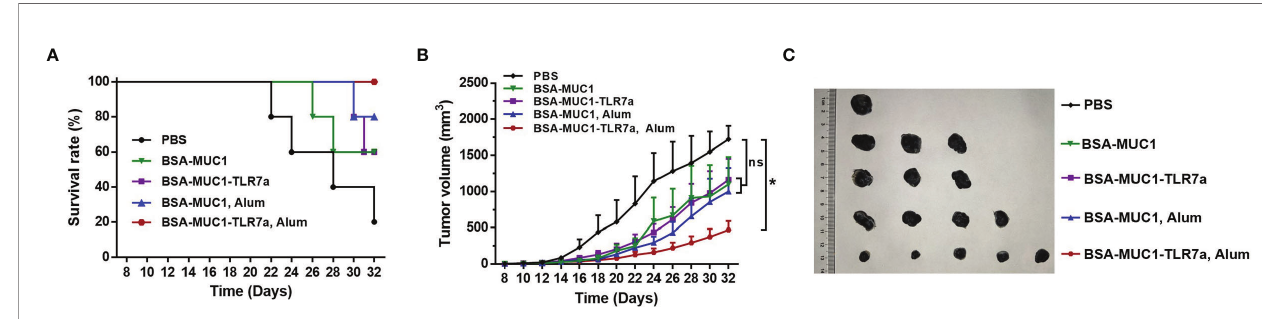
FIGURE 6 | Survival rate of mice (A) and tumor growth (B) of mice injected with different samples. (C) Tumor images of mice euthanized. Asterisks show signi fi cant difference based on two-way ANOVA by Dunn ’ s multiple comparison test compared with PBS group (no signi fi cant difference, ns; *P